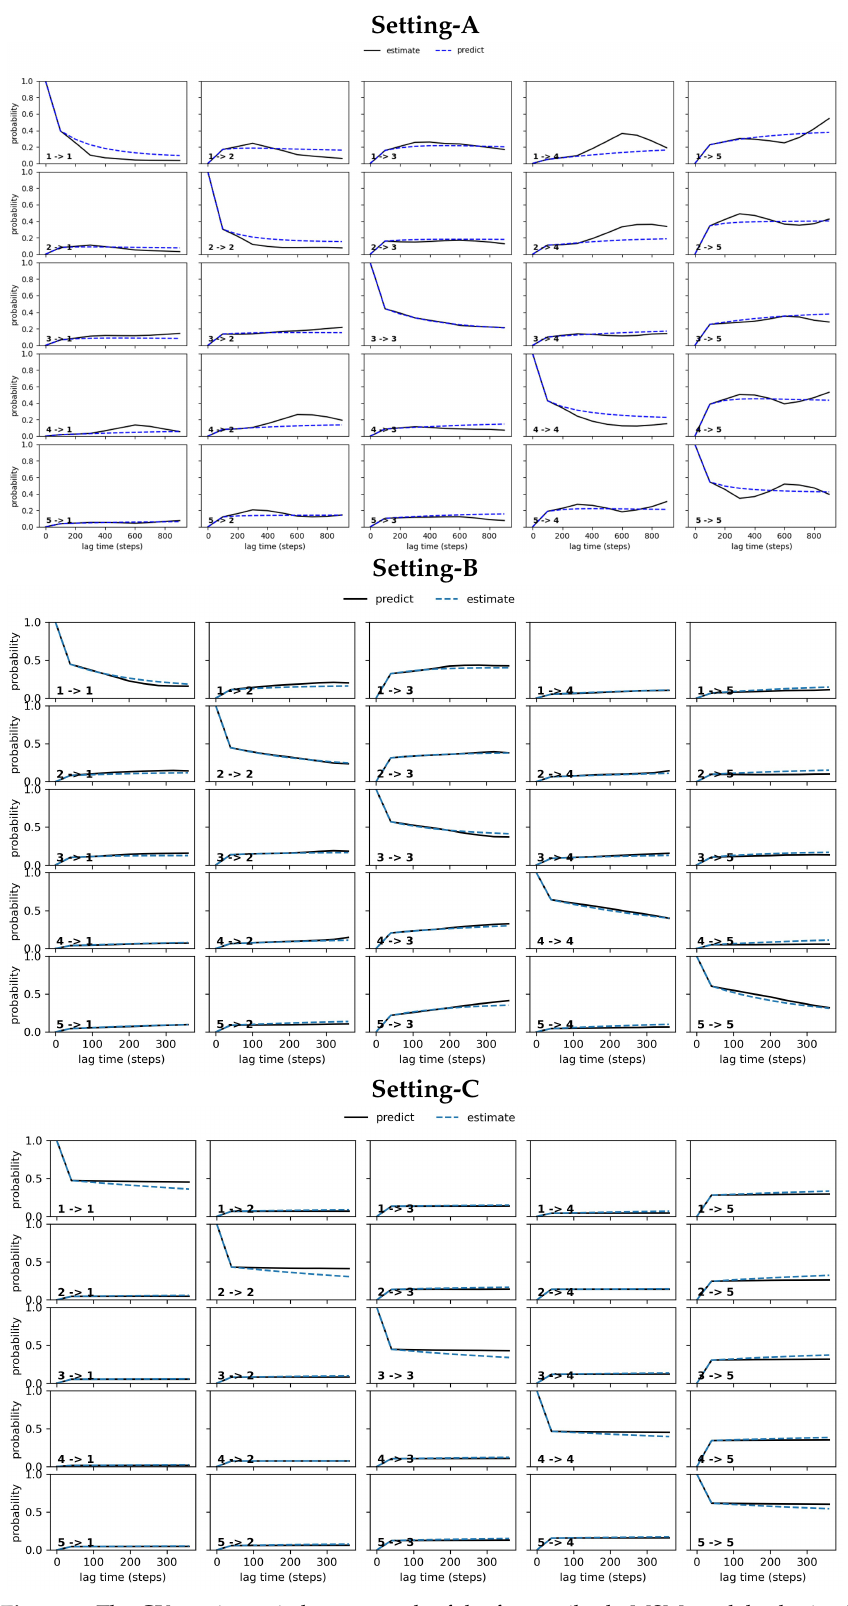
Figure 3. The CK test is carried out on each of the free antibody MSM models obtained, respectively, from ( top panel) Setting-A, ( middle panel) Setting-B, and ( bottom panel) Setting-C. Deviations between the estimated and the predicted model are large in Setting-A, gradually reduce over Setting- B, and become negligible in Setting